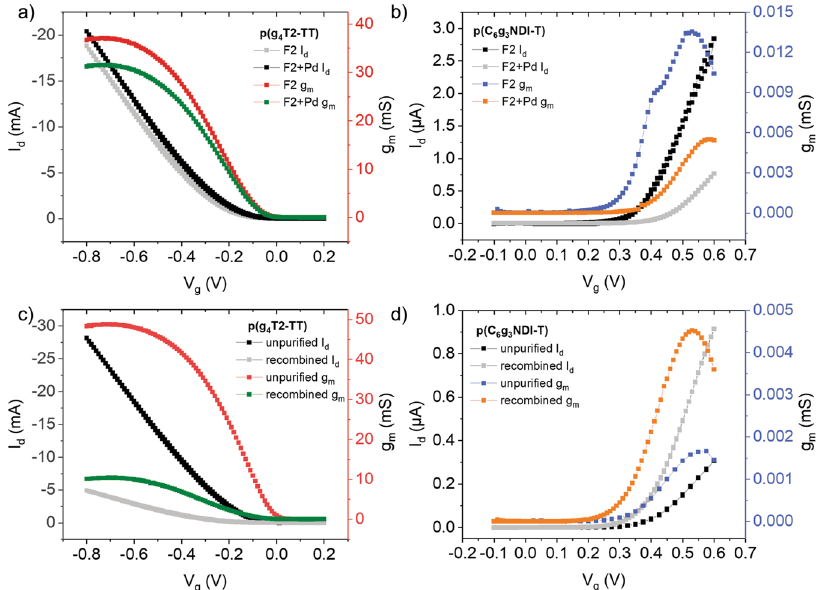
Fig. 4 | OECT transfer and transconductance characteristics before and after the reintroduction of Pd and comparing the unpuri fi ed and recombined bat- chesofeachpolymer. TheOECTtransferandtransconductancecharacteristicsfor a fraction 3 of p(g 4 T2-TT) before and after the reintroduction of 2000 ppm of Pd and b fraction 2 of p(C 6 g 3 NDI-T) before and after the reintroduction of 2000 ppm